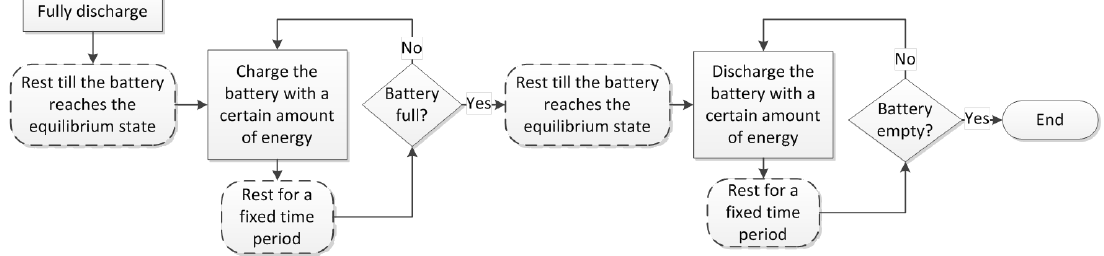
Test procedure of cte-OCV- SOC measurement and the Internal impedance circuit